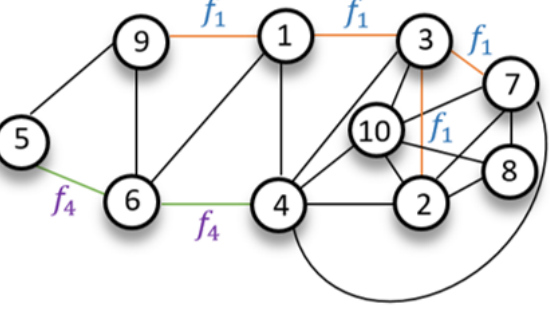
Figure 13. Virtual confinement of radios using different frequency channels.